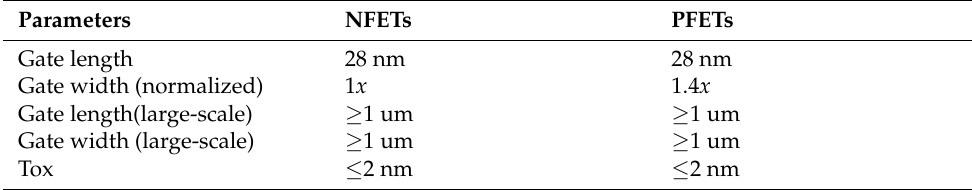
Table 1. Geometrical parameters of device structure.